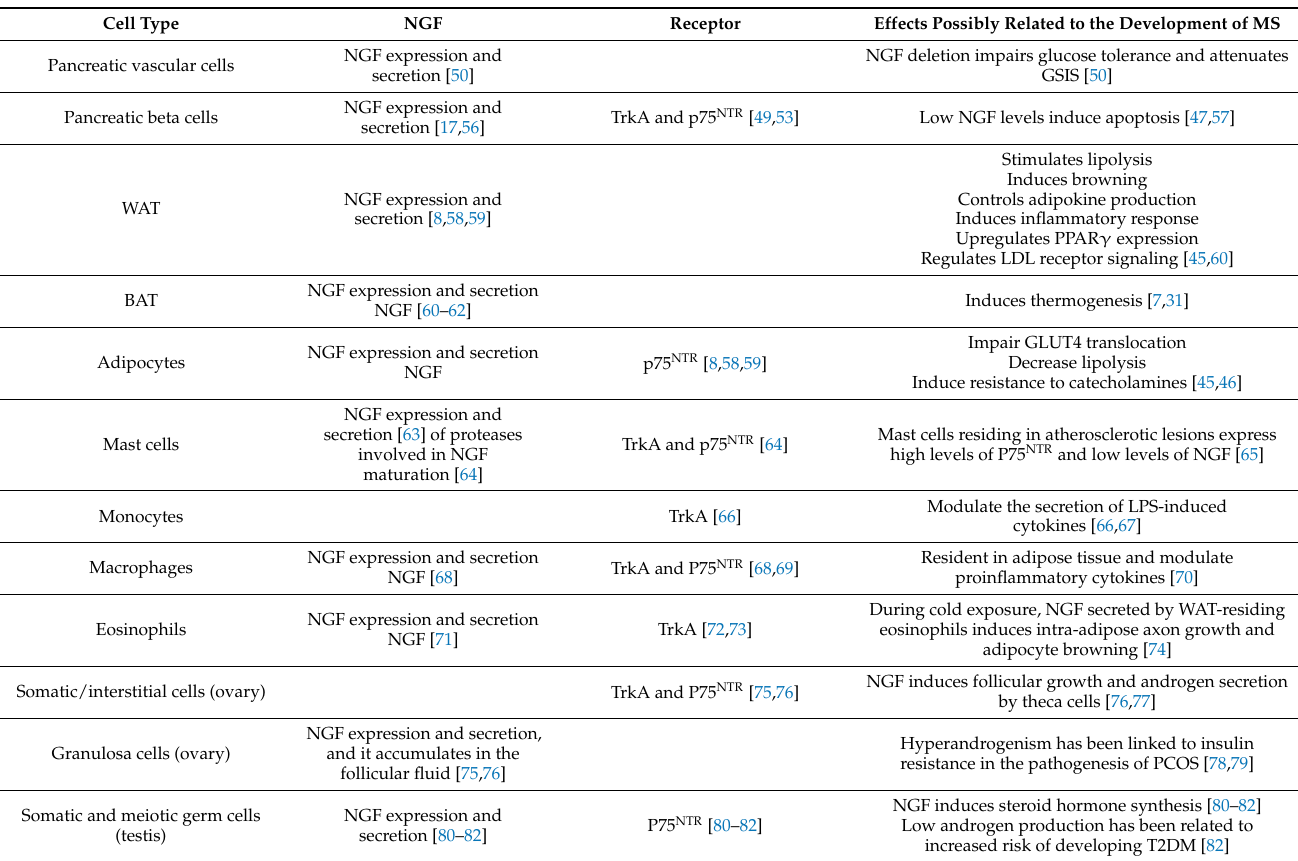
Table 2. NGF and its receptors are expressed in cells of the immunoendocrine axis implicated in the development of metabolic